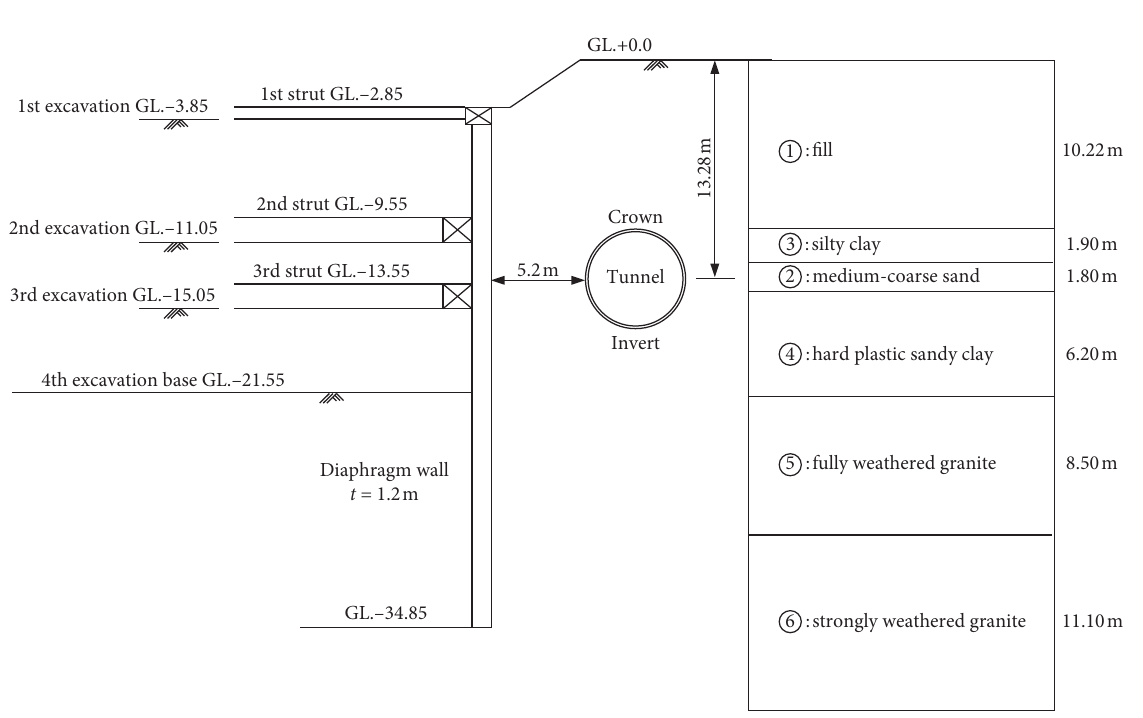
Figure 23: Profile of soil layer, excavation, and tunnel (section A-A).